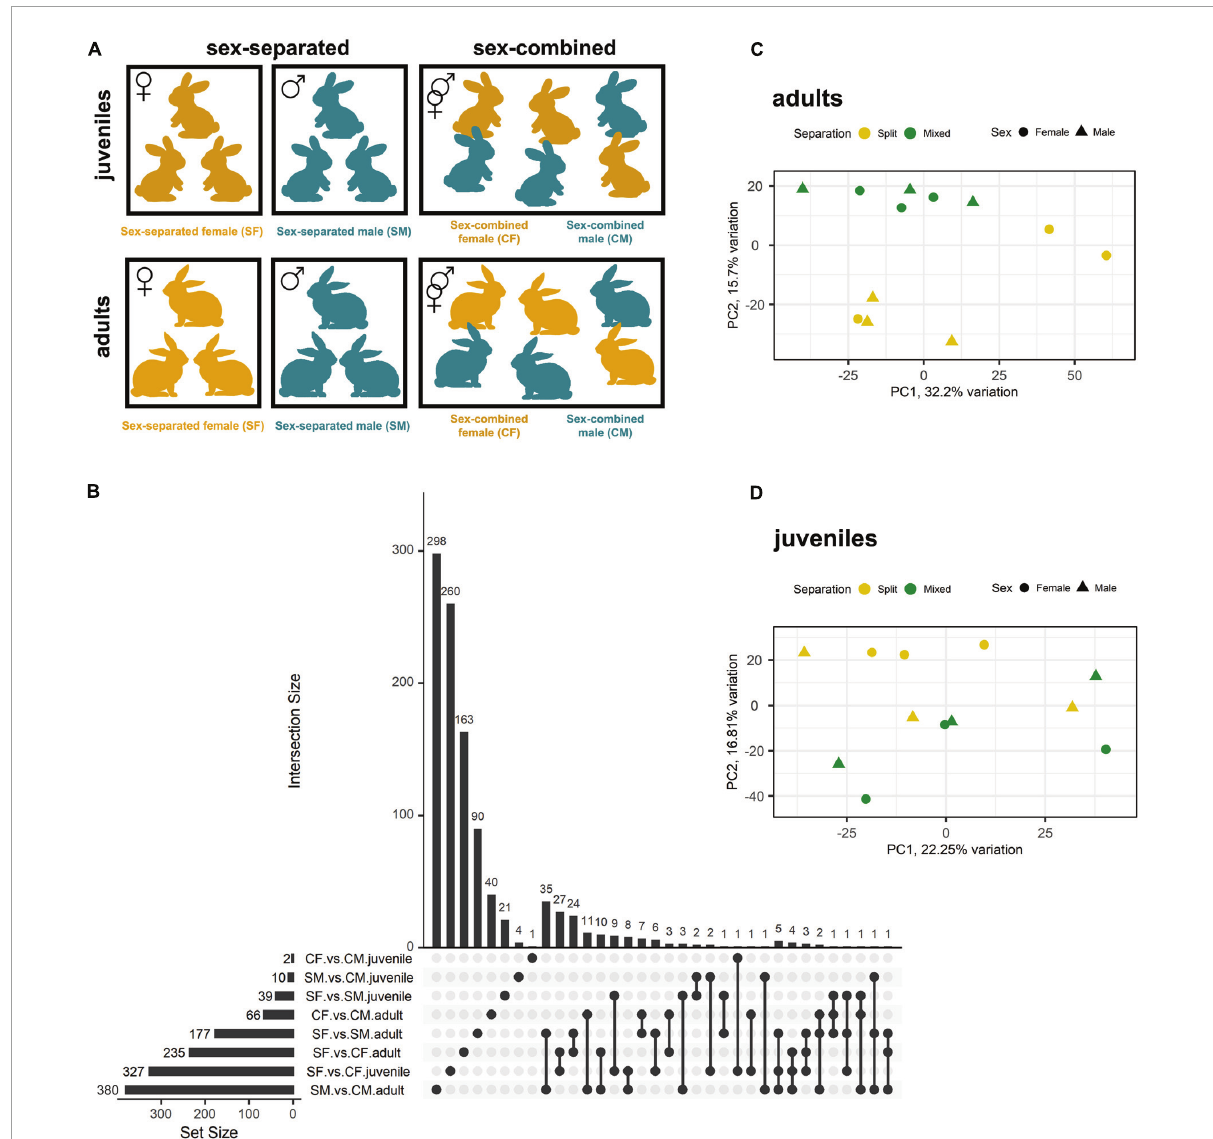
FIGURE1 Gene expression differences between male and female rabbits in VNO tissue, both in adults and juveniles, under different socio-environmental conditions. (A) Experimental design. From day 0 until day 40 [first sampling point (juveniles)] and day 180 [second sampling point (adults)], rabbits experienced either a sex-separated environment or a sex-combined environment. (B) Upsetplot showing the number of DEGs of each experimental group and those shared between groups. The bars representing the intersection size show the number of DEGs shared by the experimental groups highlighted by black dots in the matrix panel below. (C,D) Principal component analysis (PCA) where sex-separated and sex-combined males and females are plotted, both in panel (C) adults and panel (D)